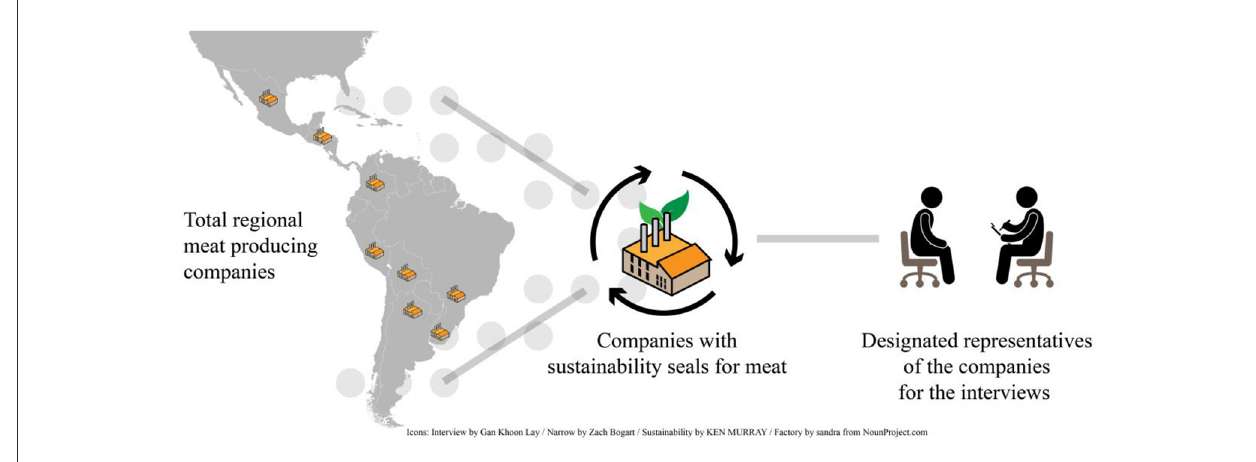
FIGURE1 Total population and sampling method: convenience sampling.